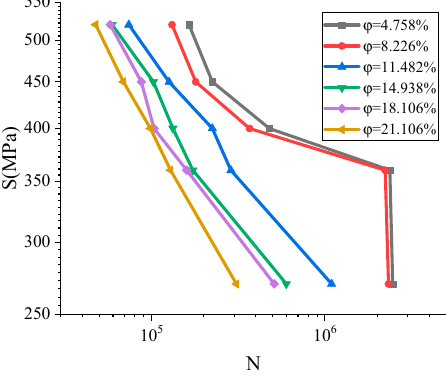
Figure 5. The S-N curves under different corrosion degrees.